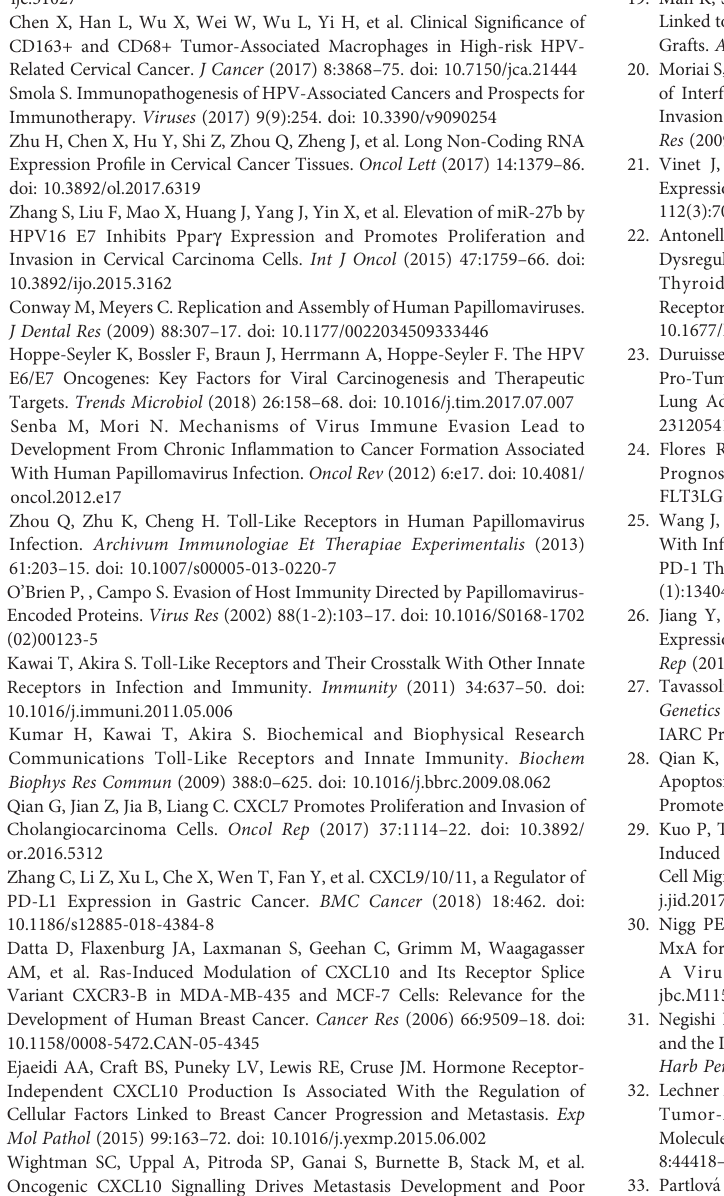
Supplementary Figure 3 | The results of tumor model by subcutaneous injection of 5 × 10 5 SiHa or KoE6/E7 SiHa cells into nude mice. (A, B) The proliferation and apoptosis of SiHa and KoE6/E7 SiHa cells were detected by CCK-8 assay and Annexin V staining apoptosis assay; (C) The volume of tumor was determined from calipermeasurementsoftumorlength(L)andwidth(W)accordingtotheformulaL× W 2 /2; (D) The histology of tumors were detected by HE staining and (E) The expression of HPV oncogenes E6 and E7 was determined by immunohistochemistry, whichfurtherpresentedthehigherexpressionofE6andE7proteininSiHagroupthan that in koE6/E7SiHa